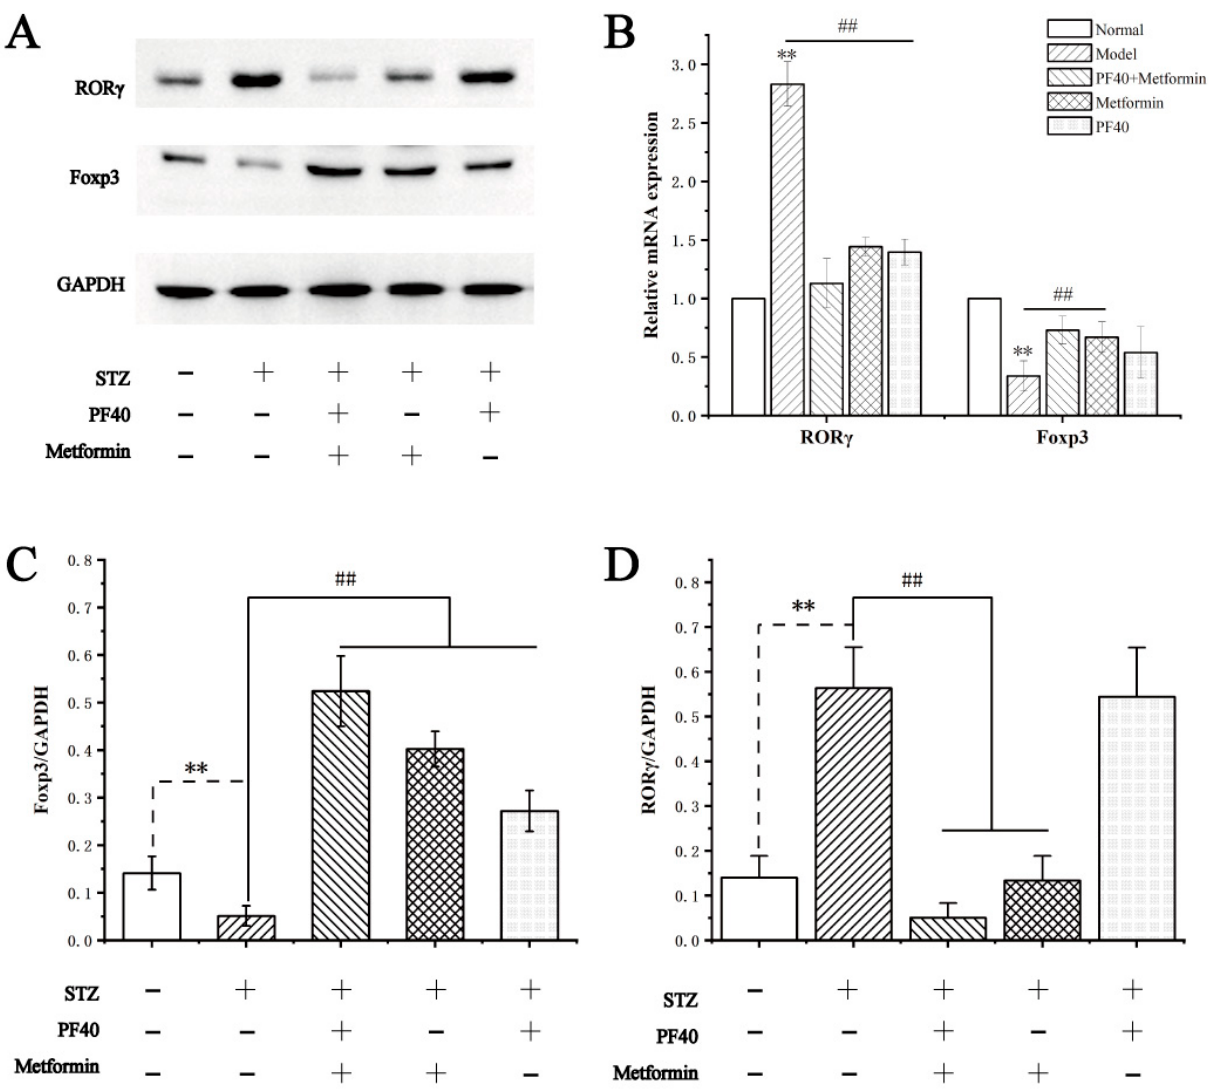
Figure 12. Effects of PF40 on the expression levels of Foxp3 and ROR γ in T2DM rats: ( A ) the relative expression levels of proteins using WB assay; ( B ) the relative gene expression via RT-qPCR assay; ( C ) the band intensity of Foxp3 quantified with Quantity One; ( D ) the band intensity of ROR γ quantified with Quantity One. Data are presented as the M ± SD ( n = 3 per group). ** p < 0.01, compared with normal group; ## p < 0.01, compared with model